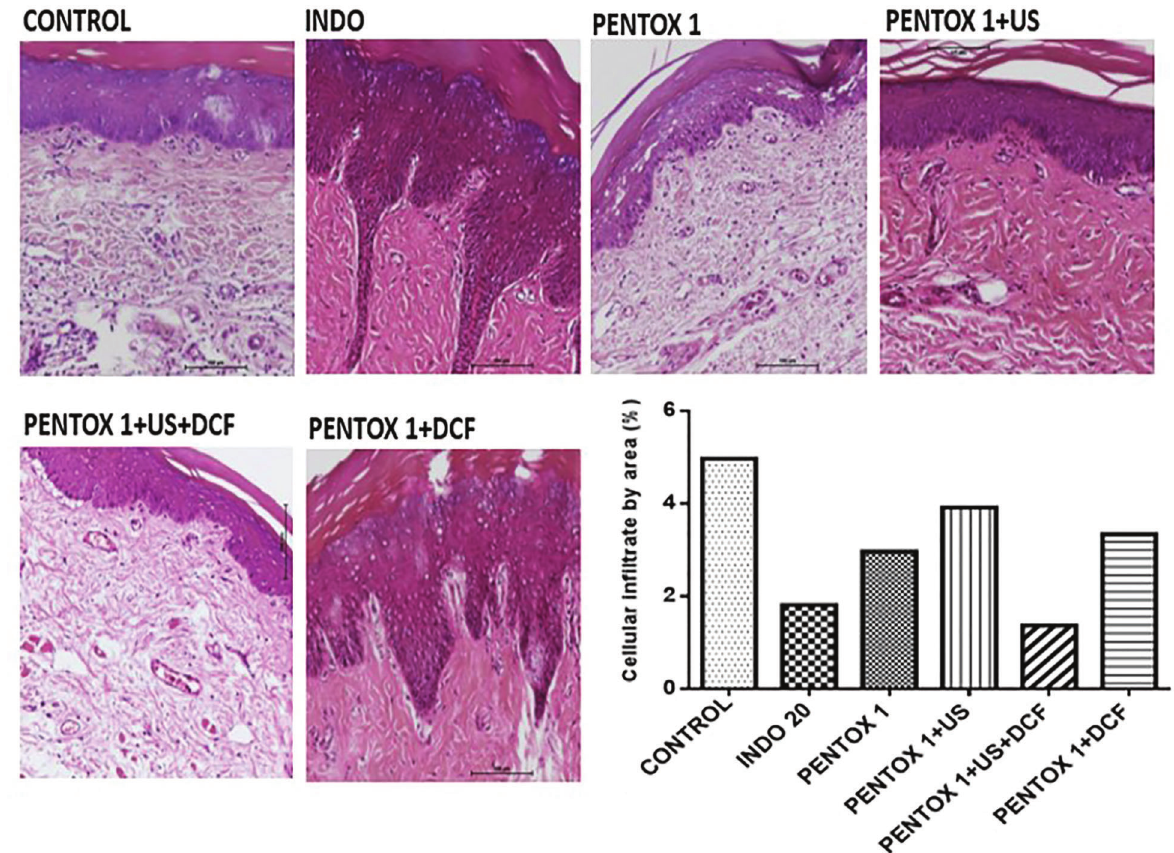
Figure 4. Photomicrographs representative of histopathological analysis (100 (cid:1) , bar=200 m m) of tissues from the right paw of rats submitted to the carrageenan-induced paw edema model, stained with hematoxylin-eosin. The images demonstrate cell in fi ltrates for the Control and groups treated with 20 mg/kg indomethacin, po (INDO 20), 1 mg pentoxifylline (PENTOX 1), 1 mg pentoxifylline associated with ultrasound (PENTOX 1 + US), 1 mg pentoxifylline associated with ultrasound, and 10 mg diclofenac (PENTOX 1 + US + DCF), 1 mg pentoxifylline associated with 10 mg diclofenac (PENTOX 1 + DCF). Percent of cellular in fi ltrate analyzed by the ImageJ program is shown in the graph. Data are reported as